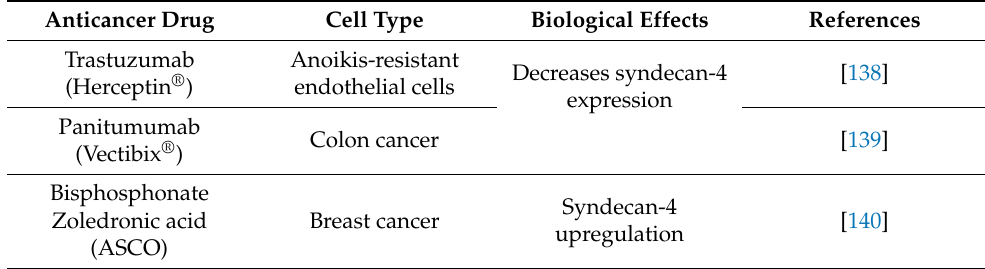
Table 2. Effects of anticancer drugs on syndecan-4 expression in different cell